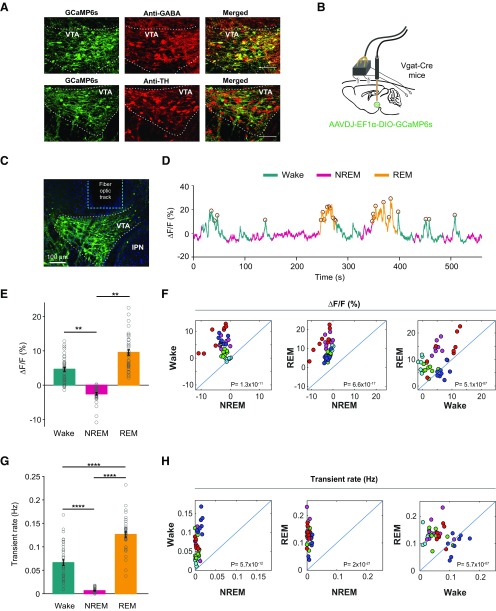
 VTA-GABAergic neurons show arousal-state-dependent alterations in population activity. A, Confocal microscopic images of AAV-DJ-EF1α-DIO-GCaMP6s expression in the VTA co-immunostained with anti-GABA (top) or anti-TH (bottom) antibodies, demonstrating selective calcium indicator expression in VTA-GABAergic neurons, but not VTA-dopaminergic neurons. B, Schematic for simultaneous recordings of VTA-GABA-GCaMP6s and EEG/EMG signals in Vgat-Cre mice. C, Representative image of GCaMP6s-expressing neurons in the VTA and the fiber optic tract for recording. D, Representative fluorescence trace color-coded by arousal state (wake, NREM sleep, and REM sleep). Identified transients are denoted by open circles. E, Mean ± SEM fluorescence during wake, NREM sleep, and REM sleep (two-way RM ANOVA between mice and arousal state; mice, F(7,31) = 0.006, p > 0.99, arousal state, F(2,62) = 8.075, p = 0.0008, followed by Tukey’s post hoc tests, wake vs NREM p > 0.99, wake vs REM p = 0.0027, NREM vs REM p = 0.0027). F, Scatter plots comparing mean %ΔF/F values for pairs of arousal states (paired samples t tests, wake vs NREM, t(38) = −9.8881, p = 4.6 × 10−12; REM vs NREM, t(38) = −14.8166, p = 2.2 × 10−17; wake vs REM, t(38) = −6.387, p = 1.68 × 10−7). Each dot represents a single trial. The different colors represent different mice. G, Transient rate (Hz) for wake, NREM sleep, and REM sleep (two-way RM ANOVA between mice and arousal state; mice, F(7,31) = 0.7776, p = 0.61, arousal state, F(2,62) = 117.8, p < 1 × 10−15, followed by Tukey’s post hoc tests, wake vs NREM = 4.39 × 10−10, wake vs REM p = 3.99 × 10−10, NREM vs REM p = 1.89 × 10−11). H, Scatter plots comparing mean transient rate values among each pair of arousal state (paired samples t tests, wake vs NREM, t(38) = −10.2078, p = 1.9 × 10−12; REM vs NREM, t(38) = −20.1677, p = 6.7 × 10−22; wake vs REM, t(38) = −6.3469, p = 1.9 × 10−7). Each dot represents a single trial. The different colors represent different mice. *, 0.001 < p ≤ 0.01; ****, p ≤ 0.0001.